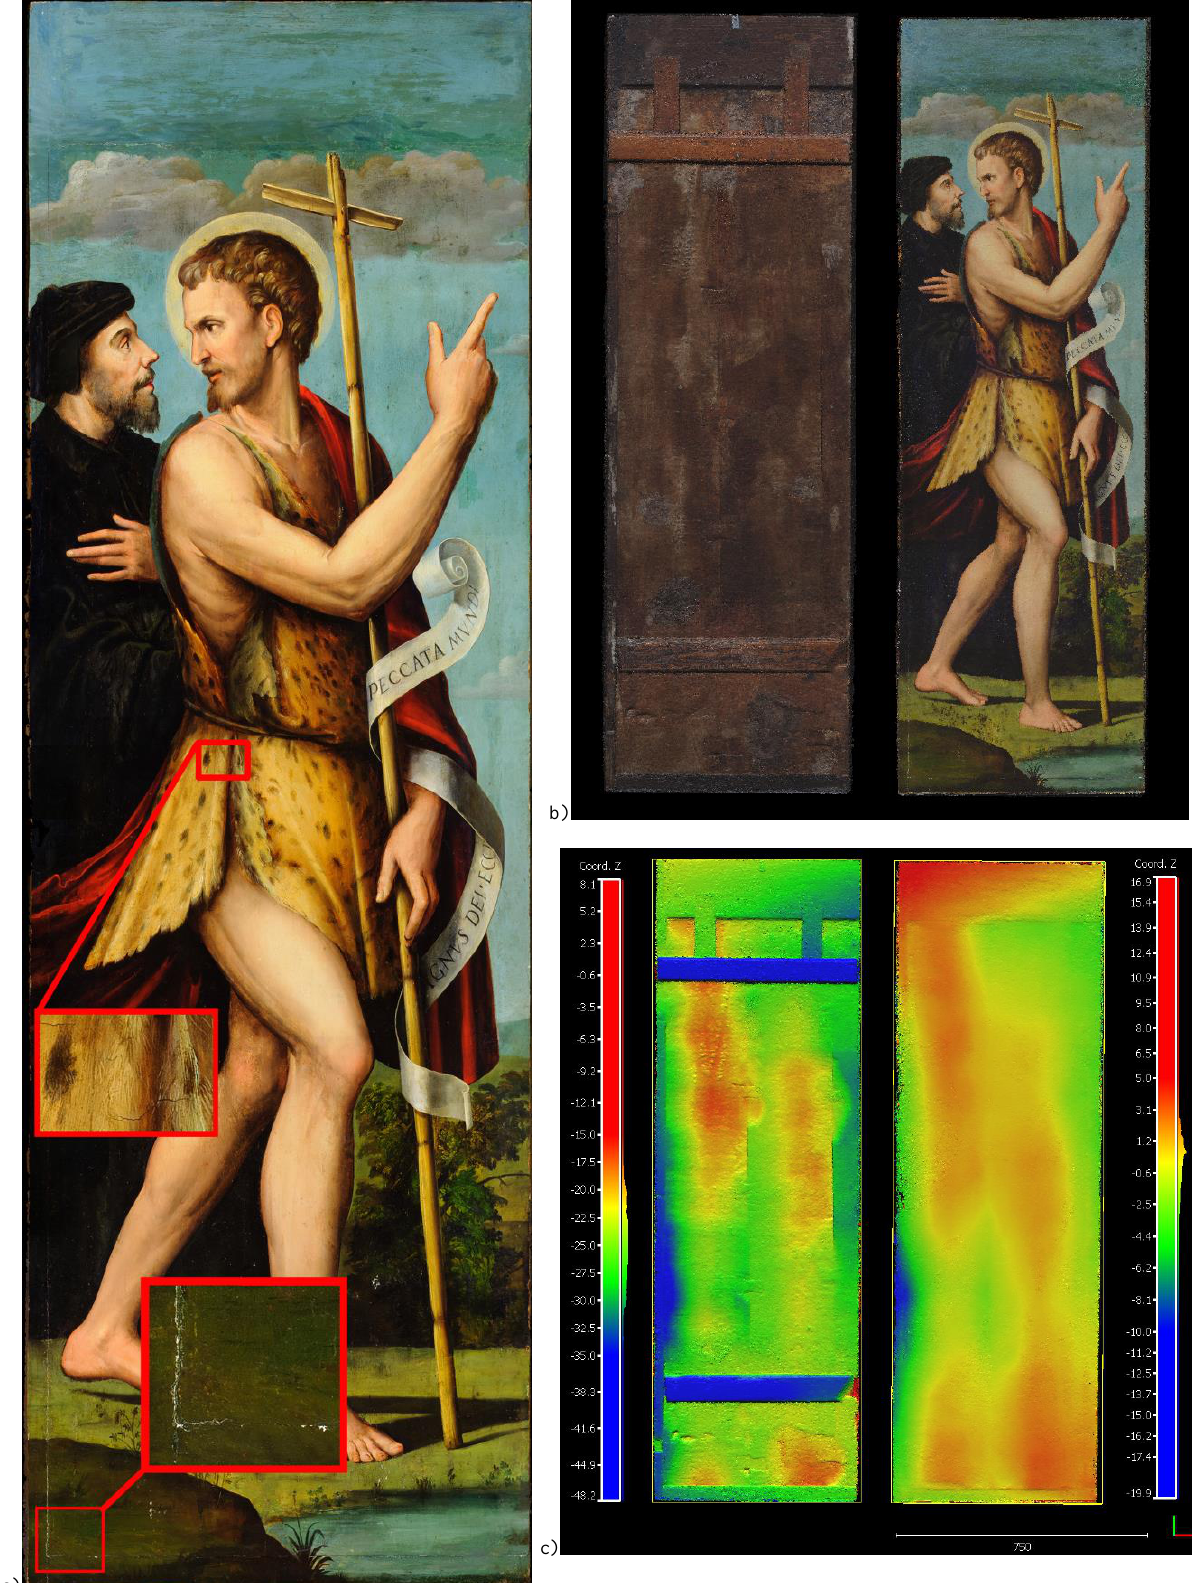
Figure 5. Analysis of the Saint John the Baptist painting. A 0.2 mm resolution orthophoto with closer views of some hairline fractures (a). Coloured dense point clouds of both sides of the painting, ca 3 mil. points per side (b). 3D coordinates of the photogrammetric dense point cloud coded according to the distances from the least square plane computed on the painting surface